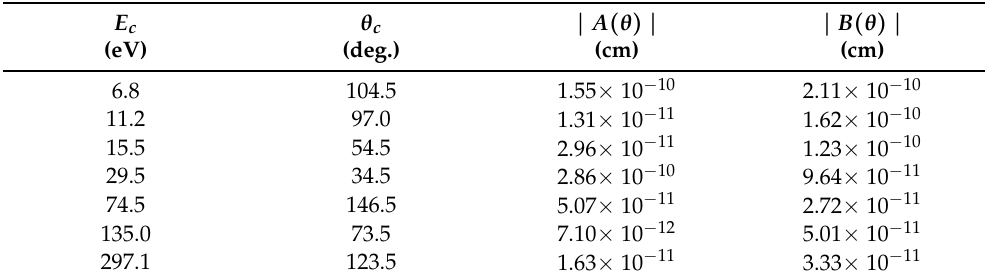
Table 1. The energy and angular positions and the values of direct and spin-flip scattering amplitudes of the deep minima (DM) in the DCS for elastic e − − Ni scattering.